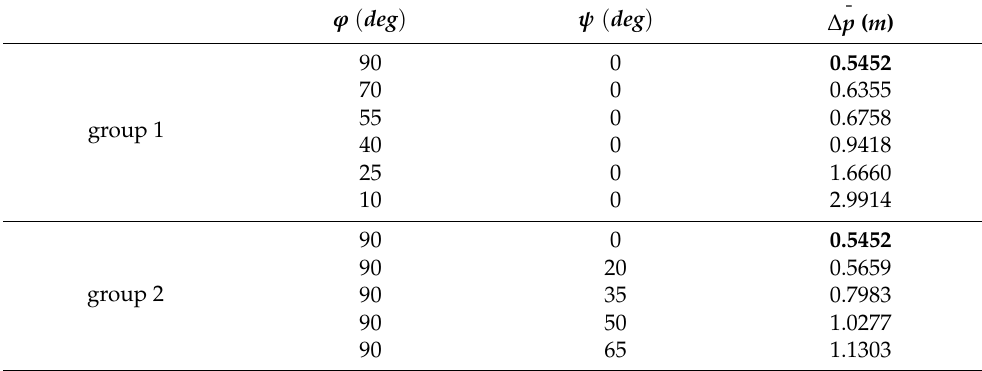
Table 11. The 3D RMSPE ∆ p environments for the NLOS condition. ϕ and ψ for the NLOS condition.